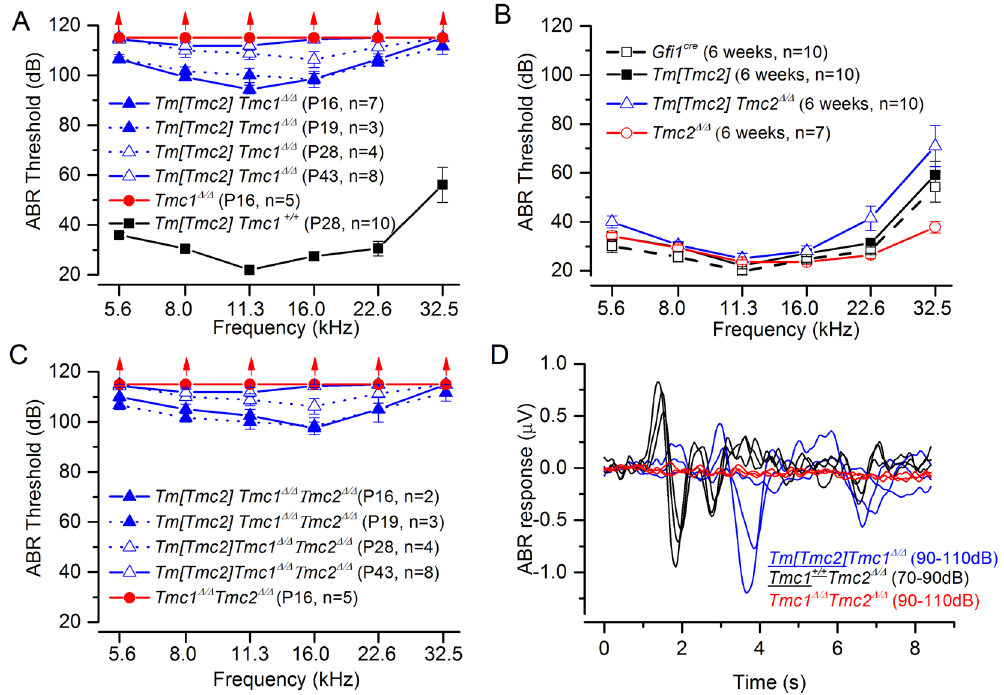
Figure 6. Gfi1 Cre inducible expression of Tm [ Tmc2 ] in absence of Tmc1 restore mild ABR sensitivity. Auditory brainstem responses were recorded in knockin mice crossed to Gfi1 Cre expressing mice to obtain Tm [ Tmc2 ] expression in absence of Tmc1 ( A ), Tmc2 ( B ) or both ( C ). ABR were detected for sound levels above 80 dB in mice that expressed the Tm [ Tmc2 ] in absence of Tmc1 or Tmc1 and Tmc2 at P16. Responses gradually disappeared and the mice were profoundly deaf by 6 weeks of age ( A , C ). While mild high frequency hearing loss was observed in mice expressing Tm [ Tmc2 ] in presence of Tmc1 , the loss was also evident in Gfi1 Cre control mice ( Tmc1 + / + Tmc2 + / + Gfi1 cre/ + ) demonstrating that this feature resulted from background strains rather than expression of Tm [ Tmc2 ] itself ( B ). Responses observed at P16 had longer latencies which resulted in altered ABR ( D ). Mean ±